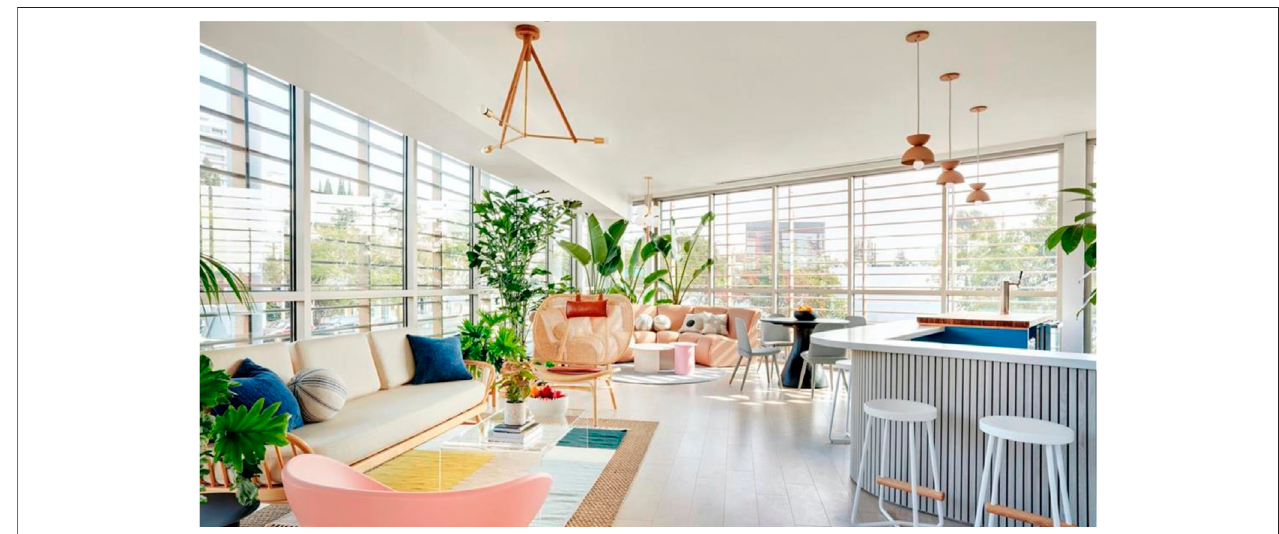
FIGURE 1 | Lounge: Credit Kara Ladd, Architectural Digest (2019), photography by Trevor Tondro